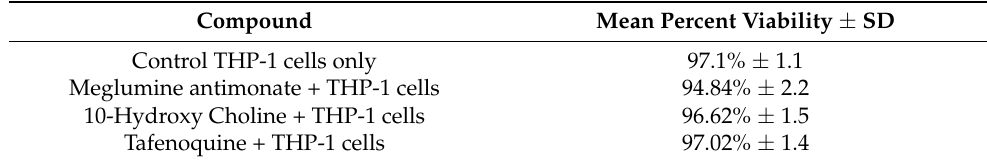
Table 1. In vitro cytotoxicity of the compounds and the standard drug (100 µ M) against THP-1 macrophages after 48